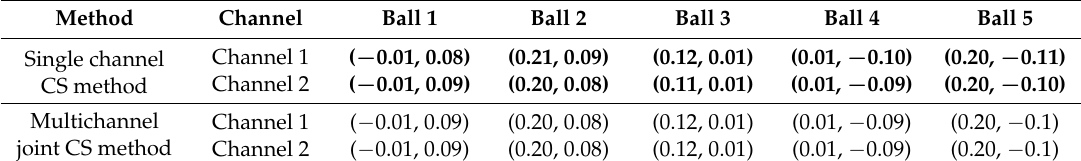
Table 2. The reconstructed positions of each metal ball when 25% of full data is used.